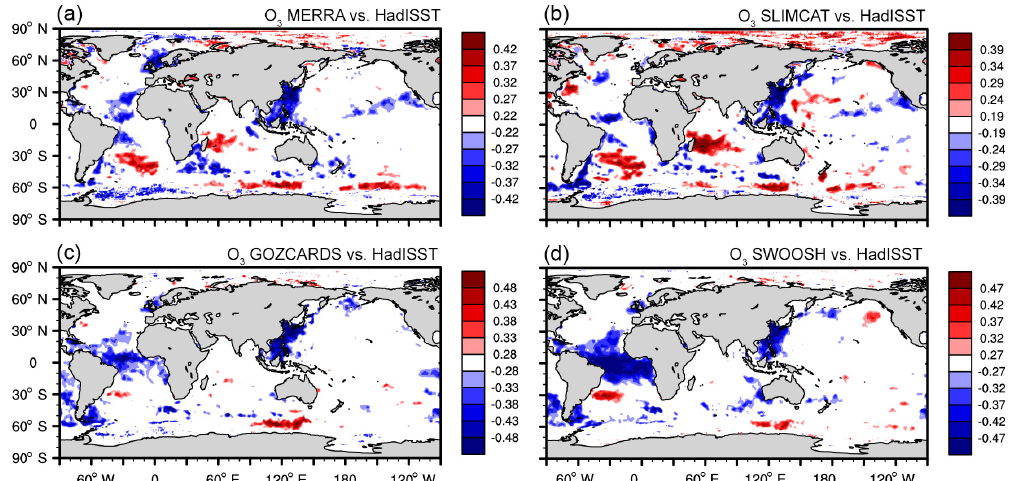
Figure 2. Correlation coefficients between southern high-latitude lower-stratospheric ozone and SST variations in austral spring. Southern high-latitude lower-stratospheric ozone variations in austral spring are averaged over the region 60–90 ◦ S at 200–50hPa for the MERRA2 (a) and SLIMCAT (b) ozone datasets and over the region 60–75 ◦ S at 200–50hPa for the GOZCARDS (c) and SWOOSH (d) ozone datasets. SST from HadISST. Only statistical significance above the 95% confidence level is colored; statistical significance was calculated using the two-tailed Student’s t test and the N eff of DOF. The seasonal cycles and linear trends were removed prior to calculating the correlation